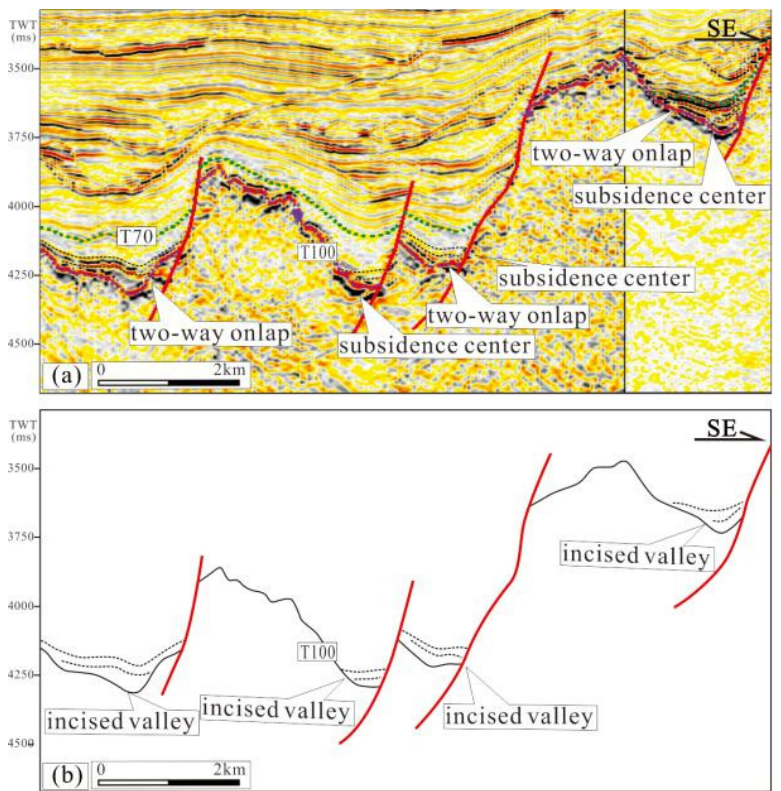
Figure 8. The small growth faults in SLS were controlled to form fault ditches that acted as source channels. ( a ) The subsidence centers formed fault ditches at the root of the boundary faults, inside of which developed two-way onlap with strong amplitude reflection; ( b ) The fault ditches acted as the incised valley.